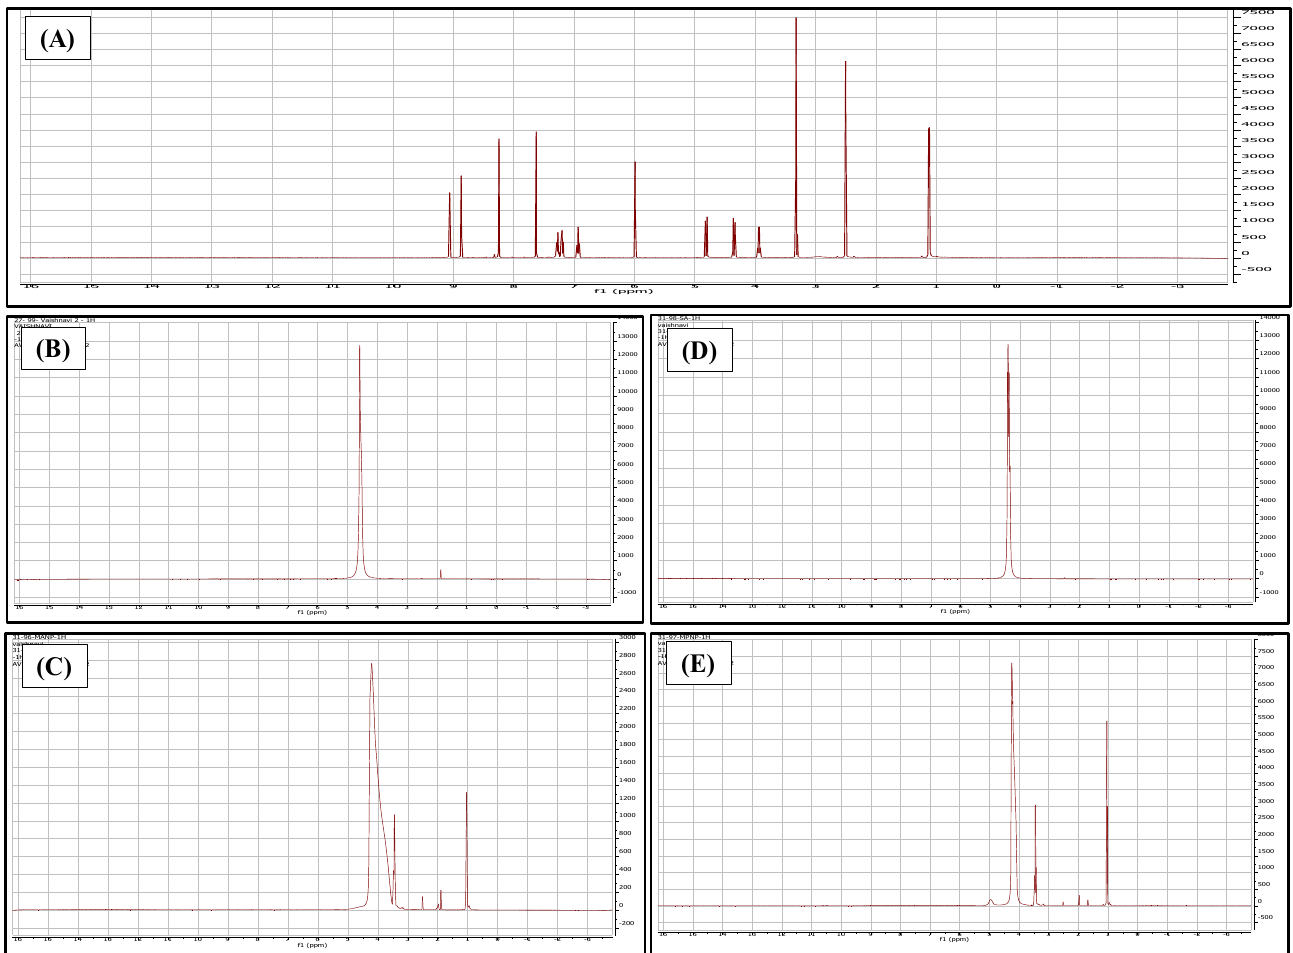
Figure 5. FT-IR spectra of voriconazole, chitosan, sodium alginate, physical mixture of drug and excipients, BC-NPs, VCZ-MA-NPs, and VCZ-MA-NPs (top to bottom). Characteristic peaks of VCZ disappeared in modified nanoparticles, while VCZ-MA-NPs, and VCZ-MP-NPs showed a similar pattern as chitosan and sodium alginate, respectively.